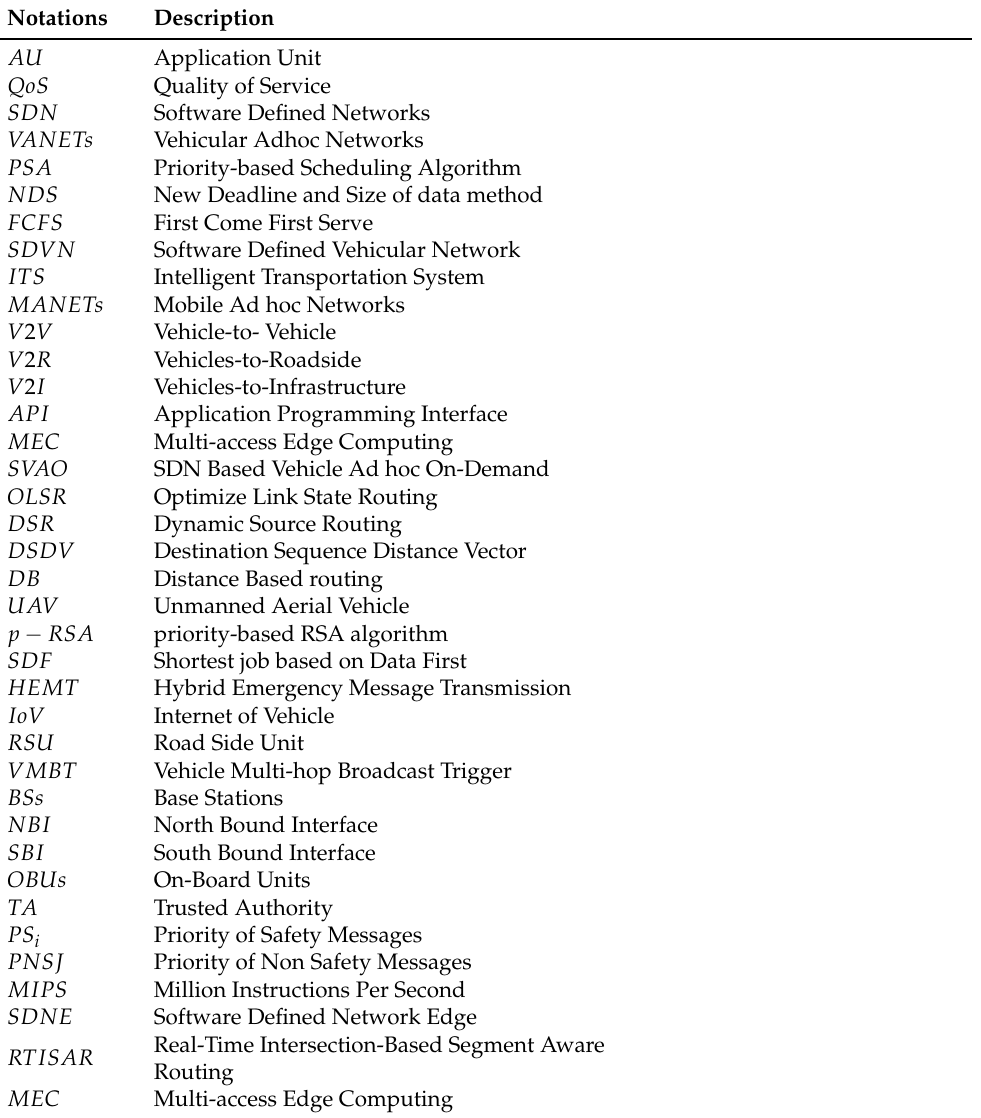
Table 1. Notations and